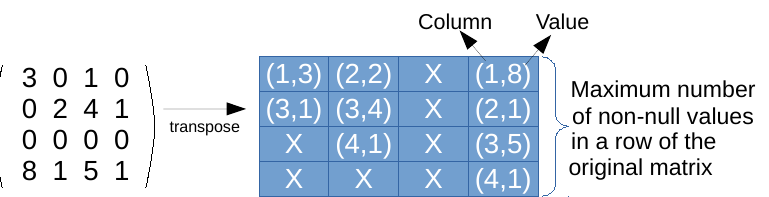
Figure 1. CSR format example. Non-zero val array stores the non-null values, columns array stores the column indexes, and row pointers are the positions where each row starts in the previous arrays.